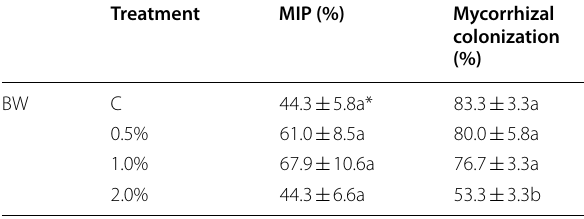
*Values (means standard errors of three replicates per treatment) followed ± by the same letter in a column are not significantly different at P < 0.05